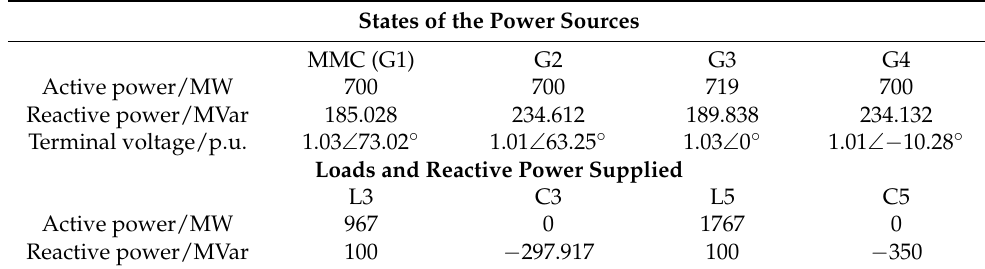
Table 1. Steady state of the 2-area 4-machine power system.